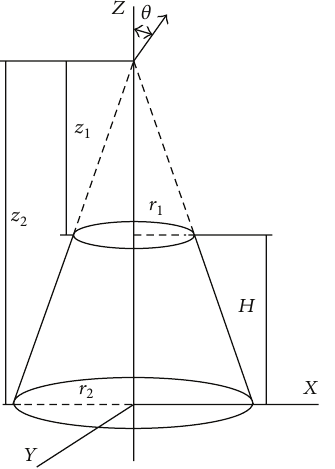
Figure 8: Geometry for the RCS calculation of a truncated cone (frustum) [38].